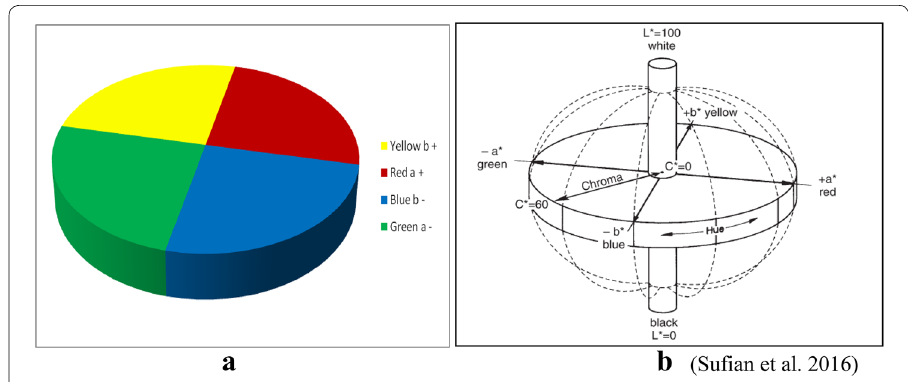
Table 4 Fastness properties of dyed cellulosic fabrics